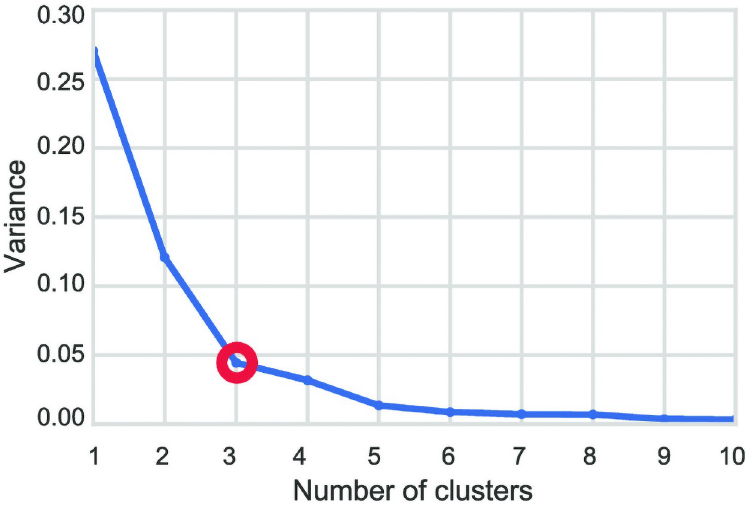
Fig 4. The ratio of the within-cluster variance to the total variance for each possible choice of K (number of clusters). The variance decreases as the data is split into more clusters until it stops decreasing significantly at k = 3 (marked by a red